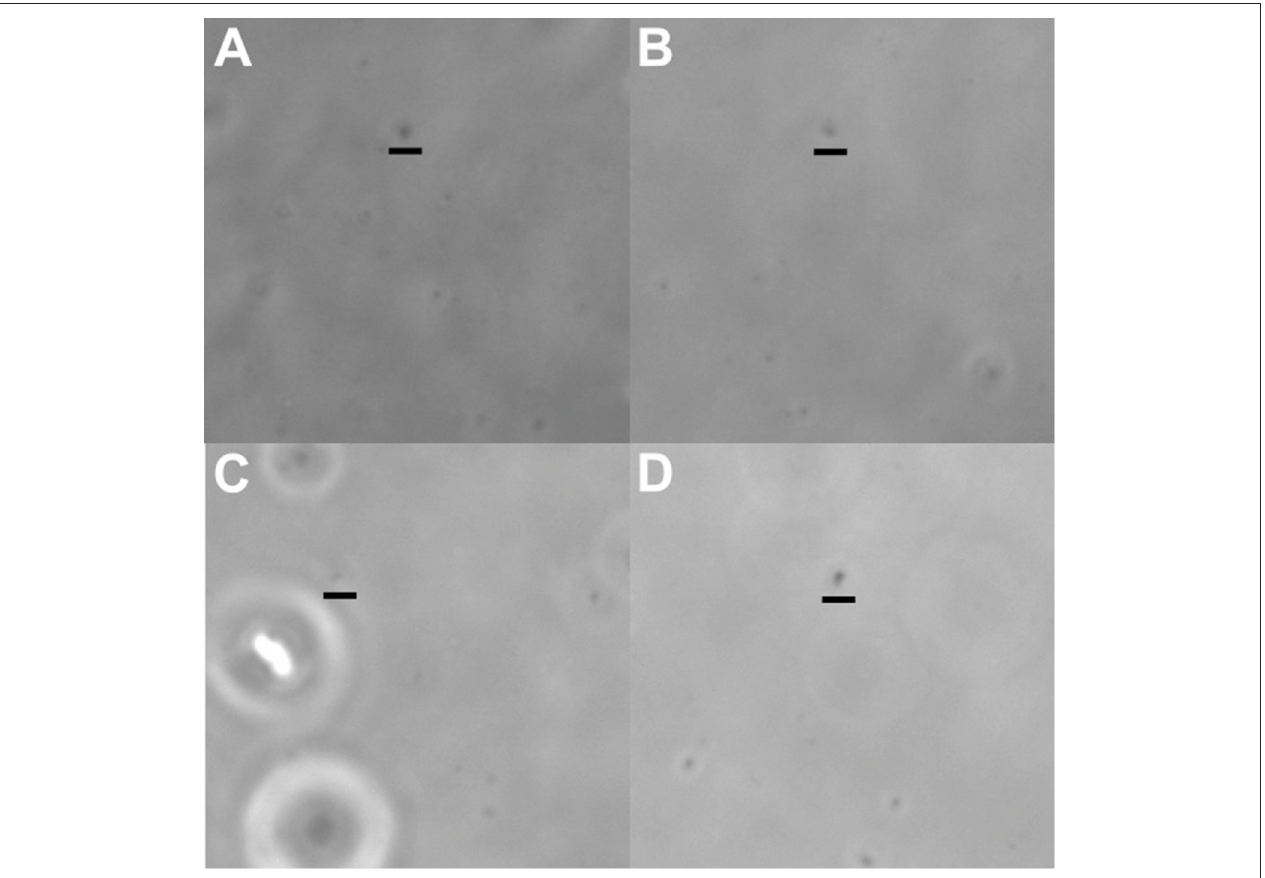
FIGURE 6 | Images of cells selected to produce the whole-genome amplification products discussed in this paper. All cells had very small morphologies, as is typical for pelagic, free-living bacterioplankton. (A) E01.OSU.003, (B) E01.OSU.005, (C) Acd.OSU.001, (D) Opi.OSU.00C . Scale bars are 2 µ m, and have been placed directly below the cells in